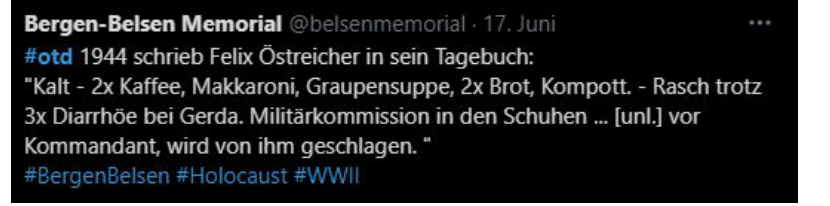
Figure 12. An On-this-day tweet for 17 June, showing a 1944 entry by Oestreicher describing the food available, his wife’s current health, and more.